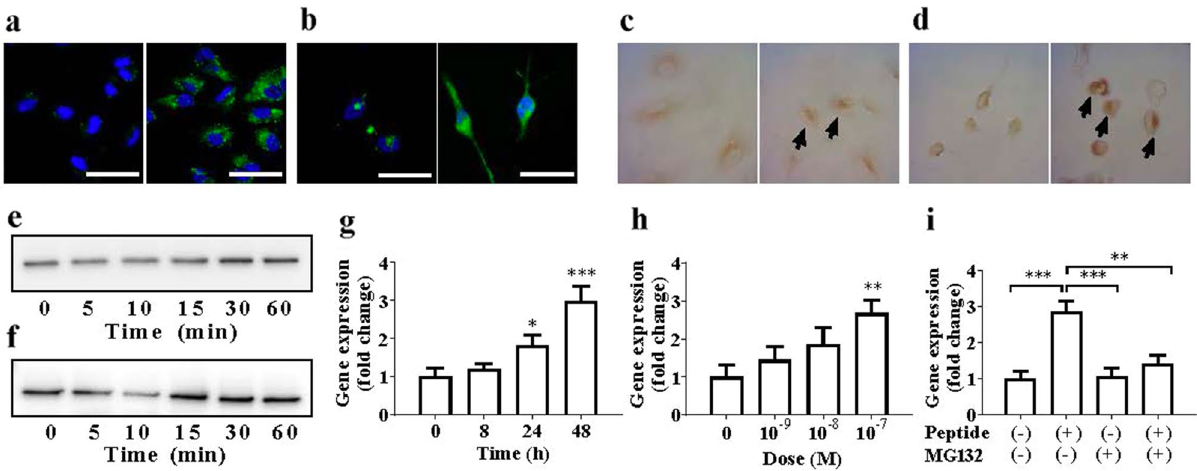
Figure 2. Cellular responses to GIP_HUMAN[22–51]. ( a, b ) Confocal laser-scanning microscopy images of the fluorescent GIP_HUMAN[22–51] peptides bound to cultured cells. Growing HAoECs ( a ) or THP1-derived macrophages deprived of serum for 16 h ( b ) were overlaid without (left panels) or with 10 –6 M FAM-GIP_ HUMAN[22–51] (right panels) for 30 or 5 min, respectively. Cells were washed, fixed, nuclei counterstained with DAPI (blue) and the cell surface-bound green fluorescence visualised. Scale bar represents 50 μm. ( c, d ) Nuclear translocation of NF-κB. HAoECs ( c ) or THP1-derived macrophages ( d ) were incubated without (left panel) or with 10 –6 M GIP_HUMAN[22–51] for 60 min, and immunocytochemical staining was performed using an NF-κB p65 subunit antibody to detect its nuclear translocation. ( e, f ) Degradation of IκB-α. HAoECs ( e ) or THP1-derived macrophages ( f ) were stimulated with 10 –7 M GIP_HUMAN[22–51] for the indicated times and subjected to western blot analysis using the anti-IκB-α antibody to assess the time-course of IκB-α degradation. The panels show the cropped blots and the full-length blots are presented in the Supplementary Information. ( g–i ) Upregulation of MMP8 gene expression by GIP_HUMAN[22–51]. HAoECs were incubated with 10 –7 M GIP_HUMAN[22–51] for the indicated times ( g ) or with indicated doses for 48 h ( h ), and MMP8 mRNA and β-actin levels were quantified. Data represent the fold changes (mean ± S.E.M) of MMP8 mRNA copies relative to β-actin mRNA ( n = 5). * p < 0.05, ** p < 0.01, *** p < 0.001 compared with vehicle. ( i ) HAoECs pre-treated with or without MG132 (500 nM) for 30 min were incubated with 10 –7 M GIP_HUMAN[22–51] and MG132 (100 nM) for 24 h and MMP8 and β-actin mRNA levels were quantified. ** p < 0.01, *** p < 0.001, compared with vehicle. The relative mRNA levels are shown as fold changes (mean ± S.E.M; n = HUMAN[22–51] on atherosclerotic plaque formation in apolipoprotein E-deficient ( ApoE −/− ) mice was investi- gated. Two osmotic mini pumps were implanted subcutaneously and loaded with saline alone, saline-dissolved GIP_HUMAN[22–51], or anti-GIP_HUMAN[22–51] IgG. The continuous infusion commenced at 17 weeks of age and lasted until 21 weeks of age in all four groups of mice that were assigned to be infused with (1) saline and saline, (2) GIP_HUMAN[22–51] and saline, (3) GIP_HUMAN[22–51] and anti-GIP_HUMAN[22–51] IgG or (4) saline and anti-GIP_HUMAN[22–51] IgG. The daily food intake during the 4-week infusion period did not differ significantly between any two groups of mice (vehicle group: 3.57 ± 0.19 g/day; GIP_HUMAN[22–51] group: 3.51 ± 0.16 g/day; GIP_HUMAN[22–51] plus antibody group: 3.48 ± 0.19 g/day; antibody only group: 3.48 ± 0.22 g/day, n.s.). There were no significant differences in body weight among the four groups at any time points (Supplementary Fig. S1), nor were there any differences in serum chemistry measurements at the end of the 4-week infusion, except for an elevation of serum GIP levels in the GIP_HUMAN[22–51] plus anti-GIP_ HUMAN[22–51] IgG group (Supplementary Table S2). After 4 weeks of infusion, the atherosclerotic lesions were evaluated according to the oil red O-stained aortic surface area (Fig. 3a–d), the aortic root area (Fig. 3e–h), and the anti-MOMA-2 antibody-stained aortic root area (Fig. 3i–l). GIP_HUMAN[22–51] increased the athero- sclerotic lesion areas and atheromatous plaque formation significantly when compared with that of the vehicle infusions (Fig. 3m–o), whereas the combined infusions with the neutralising antibody inhibited the proathero- sclerotic effects caused by GIP_HUMAN[22–51] (Fig. 3c,g,k). To investigate whether chronic infusions of GIP_HUMAN[22–51] stimulated the production and/or release of bioactive substances, serum samples withdrawn from the ApoE −/− mice after 4 weeks of infusions with or without GIP_HUMAN[22–51] or anti-GIP_HUMAN[22–51] IgG, were applied to protein antibody arrays that detected 111 mouse cytokines and chemokines (Fig. 4a). The representative blots generated by these analyses showed appreciable regulation by GIP_HUMAN[22–51] and anti-GIP_HUMAN[22–51] IgG (Fig. 4b–e). The relative sig- nal intensities of a variety of protein levels induced by GIP_HUMAN[22–51] or anti-GIP_HUMAN[22–51] IgG versus the vehicle-treated control experiments were quantified (Fig. 4f,g). The infusions of GIP_HUMAN[22–51] increased the secretions of many proinflammatory and proatherosclerotic proteins, including angiopoietin-2, serum amyloid P (SAP), CXC chemokine ligand 16 (CXCL16), proprotein convertase subtilisin kexin type 9 (PCSK9), fetuin A and MMP-3, whereas the anti-GIP_HUMAN[22–51] IgG reduced the serum levels of the intercellular adhesion molecule-1 (ICAM-1), vascular cell adhesion molecule-1 (VCAM-1), fetuin A, PCSK9,